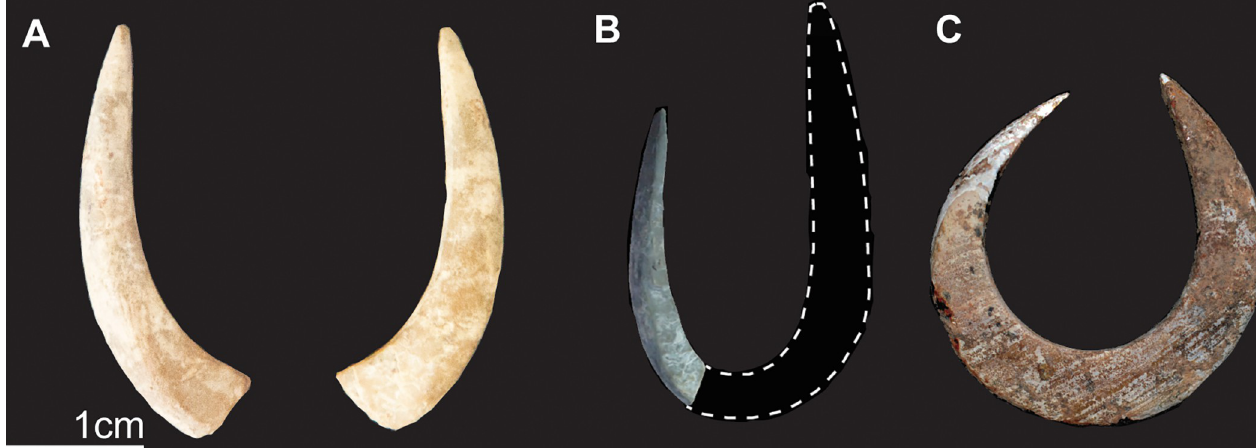
Fig 6. Fish-hooks from TLB-1. A) Broken fish-hook shaft recovered during the 2018 excavations; B) Example of fragmented jabbing hook (J-shaped) documented in 2014 from the TLB-1 burial; C) Example of rotating hook documented in 2014 on the neck of TLB-1. B and C modified from O’Connor et al. 2017